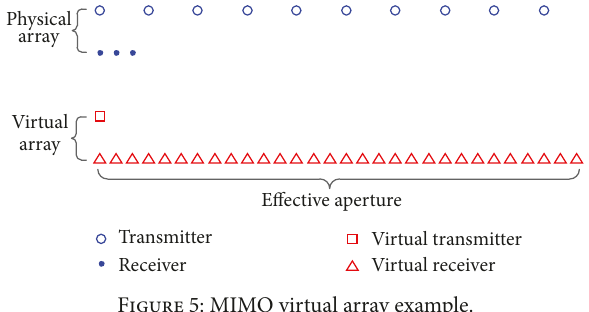
Figure 5: MIMO virtual array example.